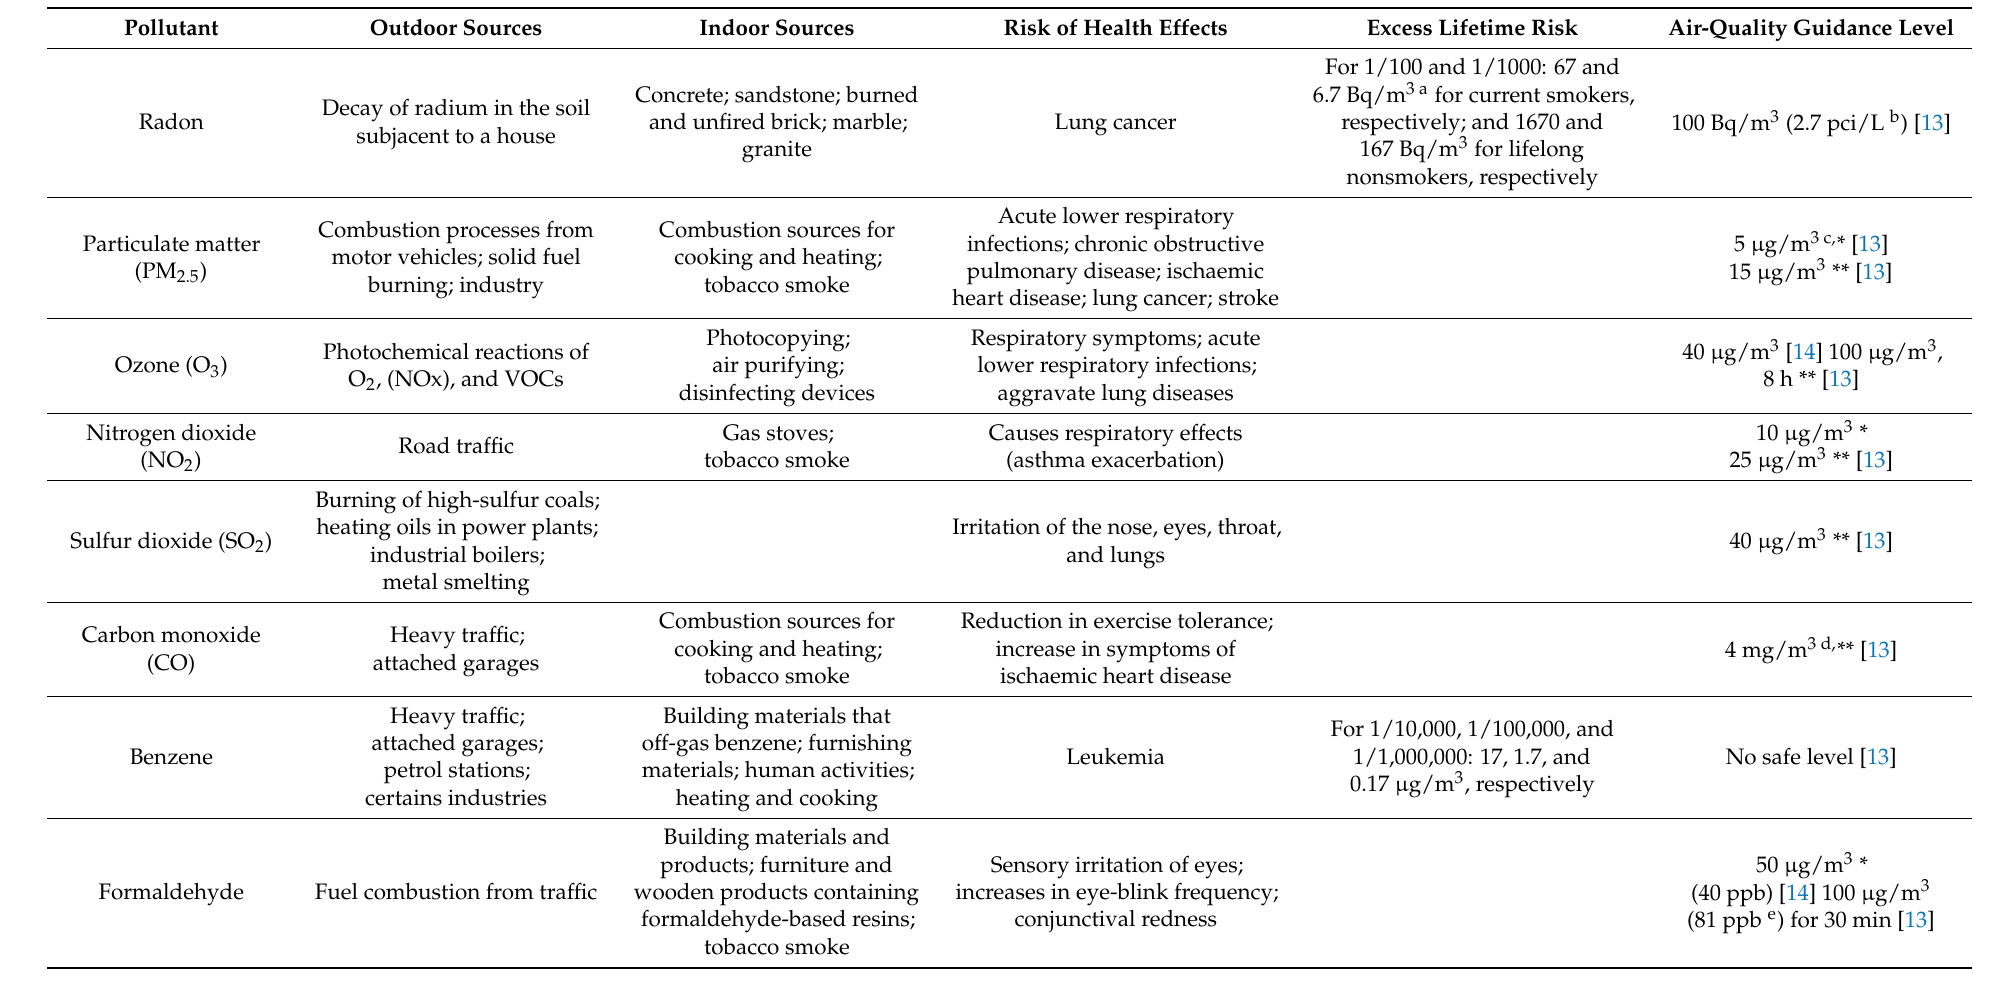
Table 1. Examples of pollutants with the lowest air quality guidelines for indoor air, sources, and health